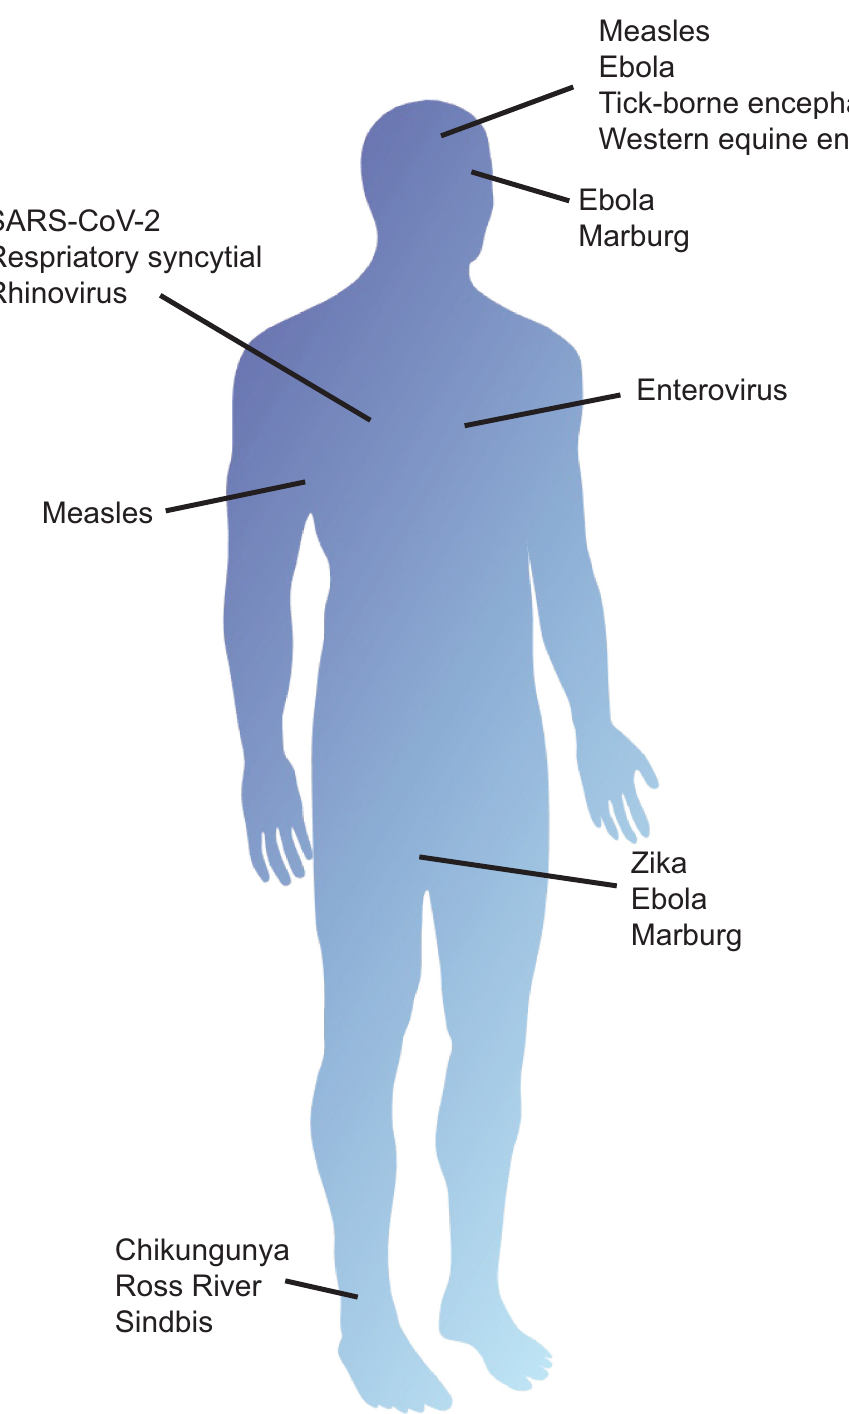
Fig 2. Sites of RNA persistence following infection. Tissues in which RNA viruses persist after infection include the nervous system, eyes, joints, lymph nodes, heart, respiratory tract, and testes. SARS-CoV-2, Severe Acute Respiratory Syndrome Coronavirus